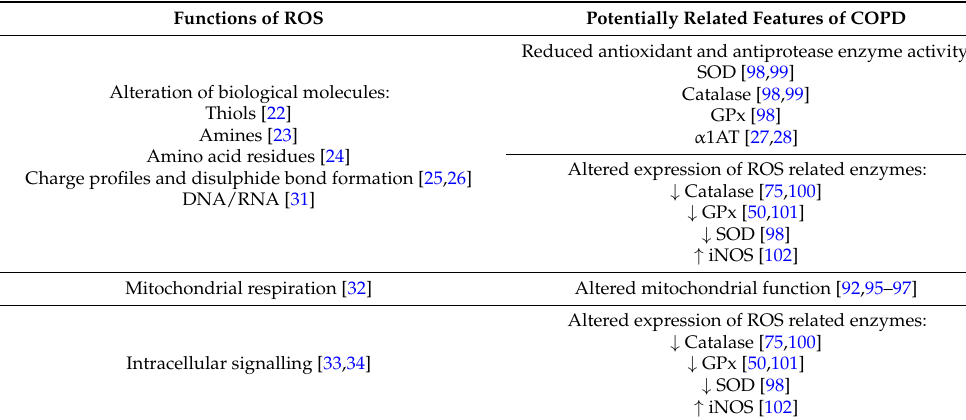
Table 1. Potential relationships between features of COPD and functions of